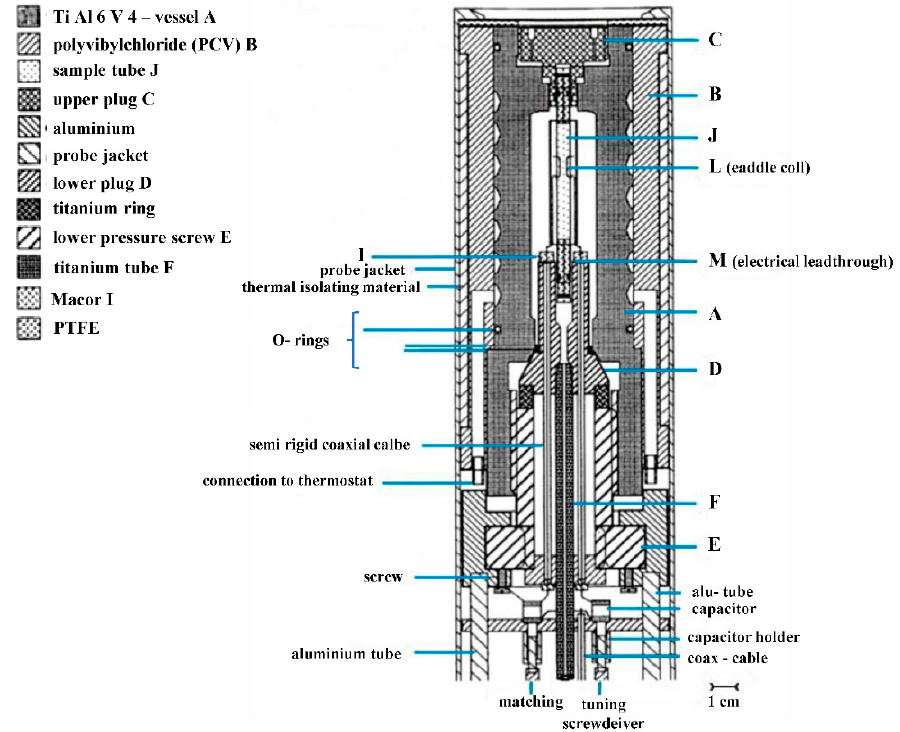
Figure 7. Schematic diagram of the titanium high-pressure NMR probe-head designed for a wide- bore magnet. Reproduced from Reference [23], with the permission of AIP Publishing.